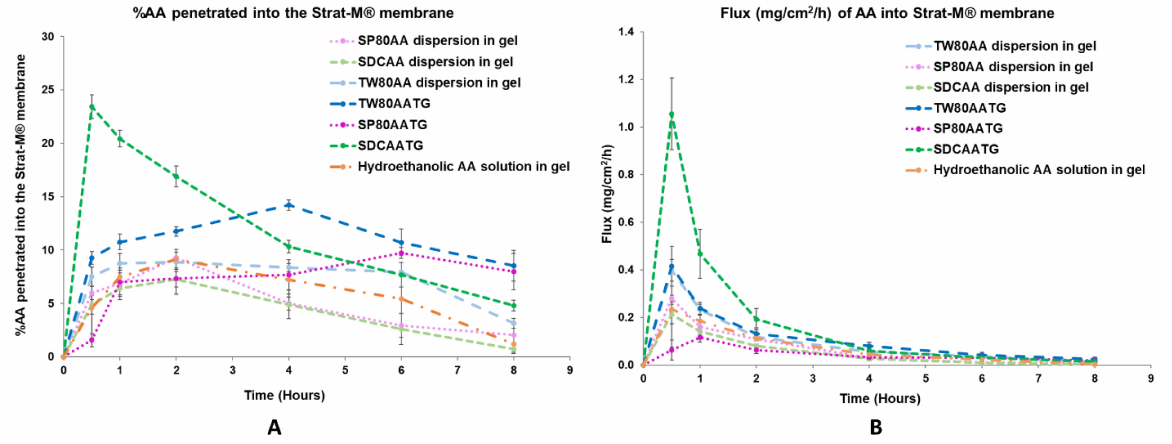
Figure 3. ( A ) In vitro permeation profile and ( B ) flux profile of the prepared AATGs and controls. Error bars indicate ± SD with n =